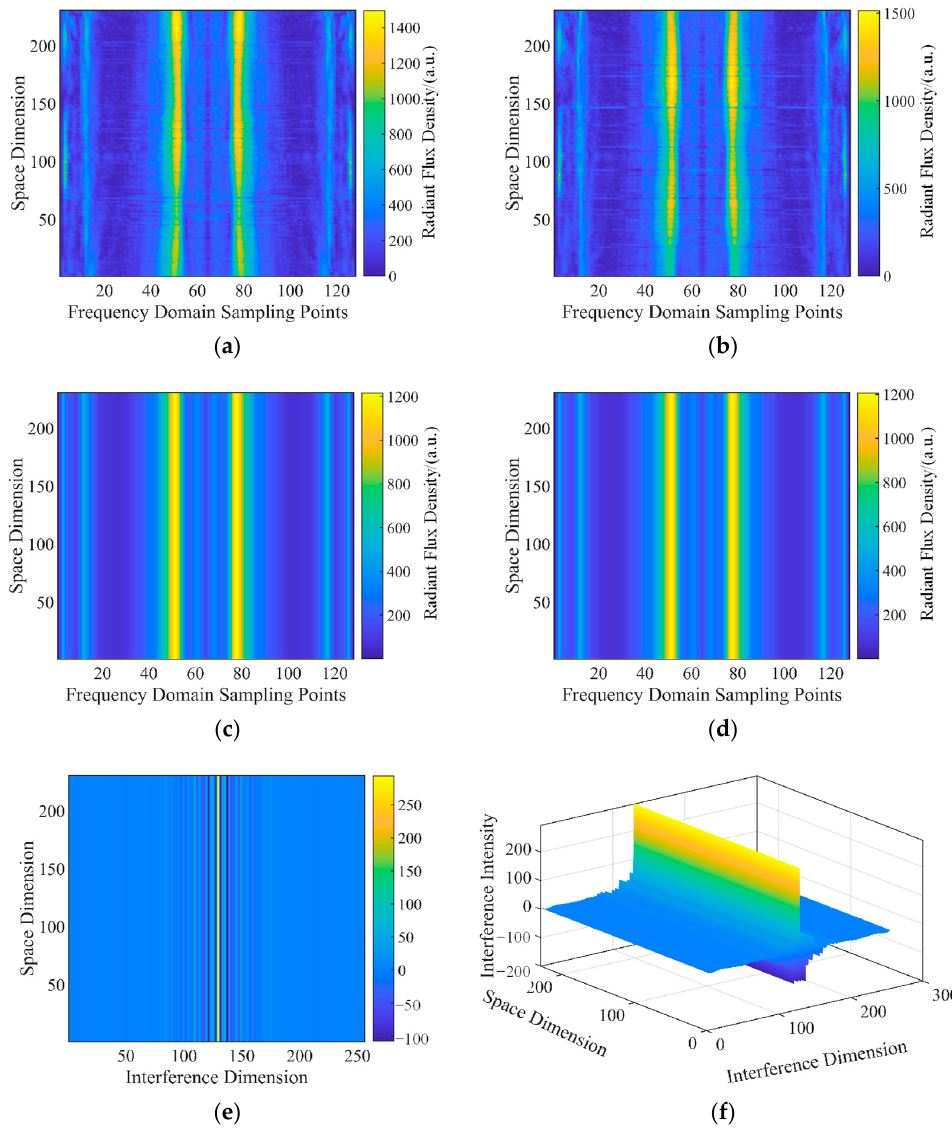
Figure 12. ( a , b ) Spectra of the flat field radiation source with different space-dimensional coordinates. ( c , d ) Column averaged spectra. ( e ) Two-dimensional interferogram after relative radiation correct. ( f ) Three-dimensional surface of the interferogram.